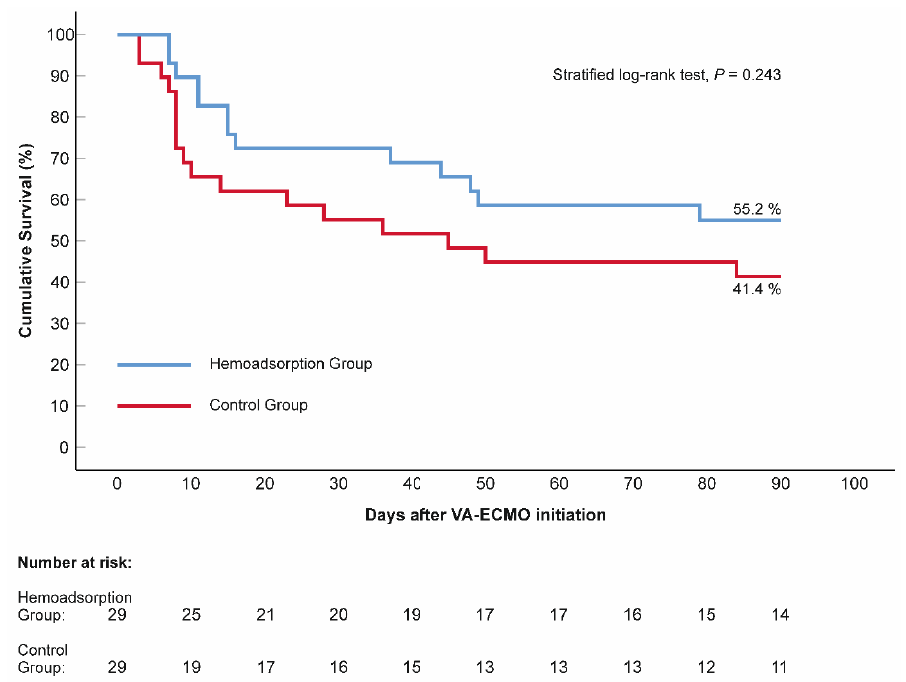
Figure 5. Kaplan–Meier estimates of cumulative 90-day survival, according to the applied venoarterial extracorporeal membrane oxygenation management. N = 58. The blue line represents the hemoadsorption group, while the red line illustrates the control group. p value (stratified log – rank test) indicates the difference in survival. VA – ECMO: venoarterial extracorporeal membrane oxygenation.